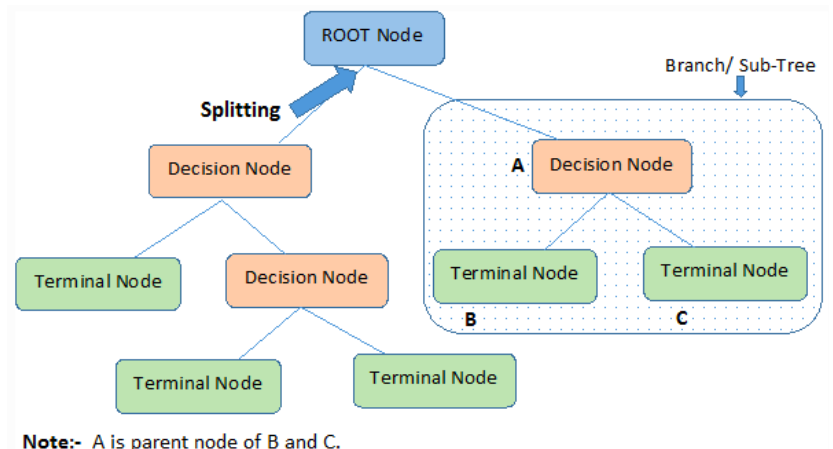
Figure 4. DT classifier [23].